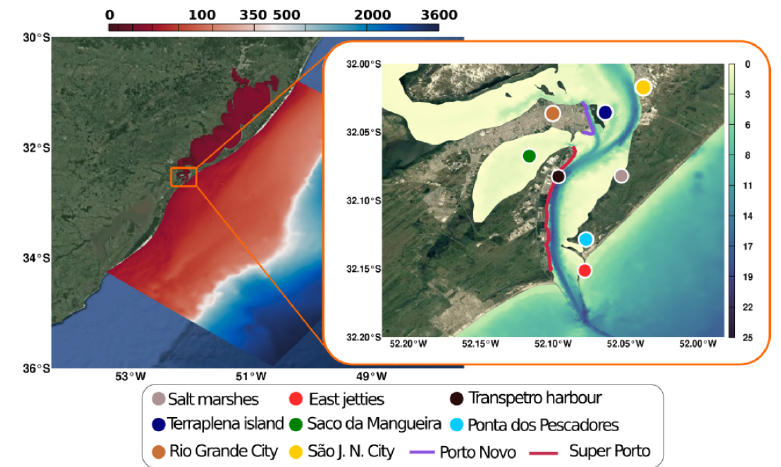
Figure 1. Representation of the computational domain. The color scale represents the bathymetry of the study area. The points and lines are references of oil